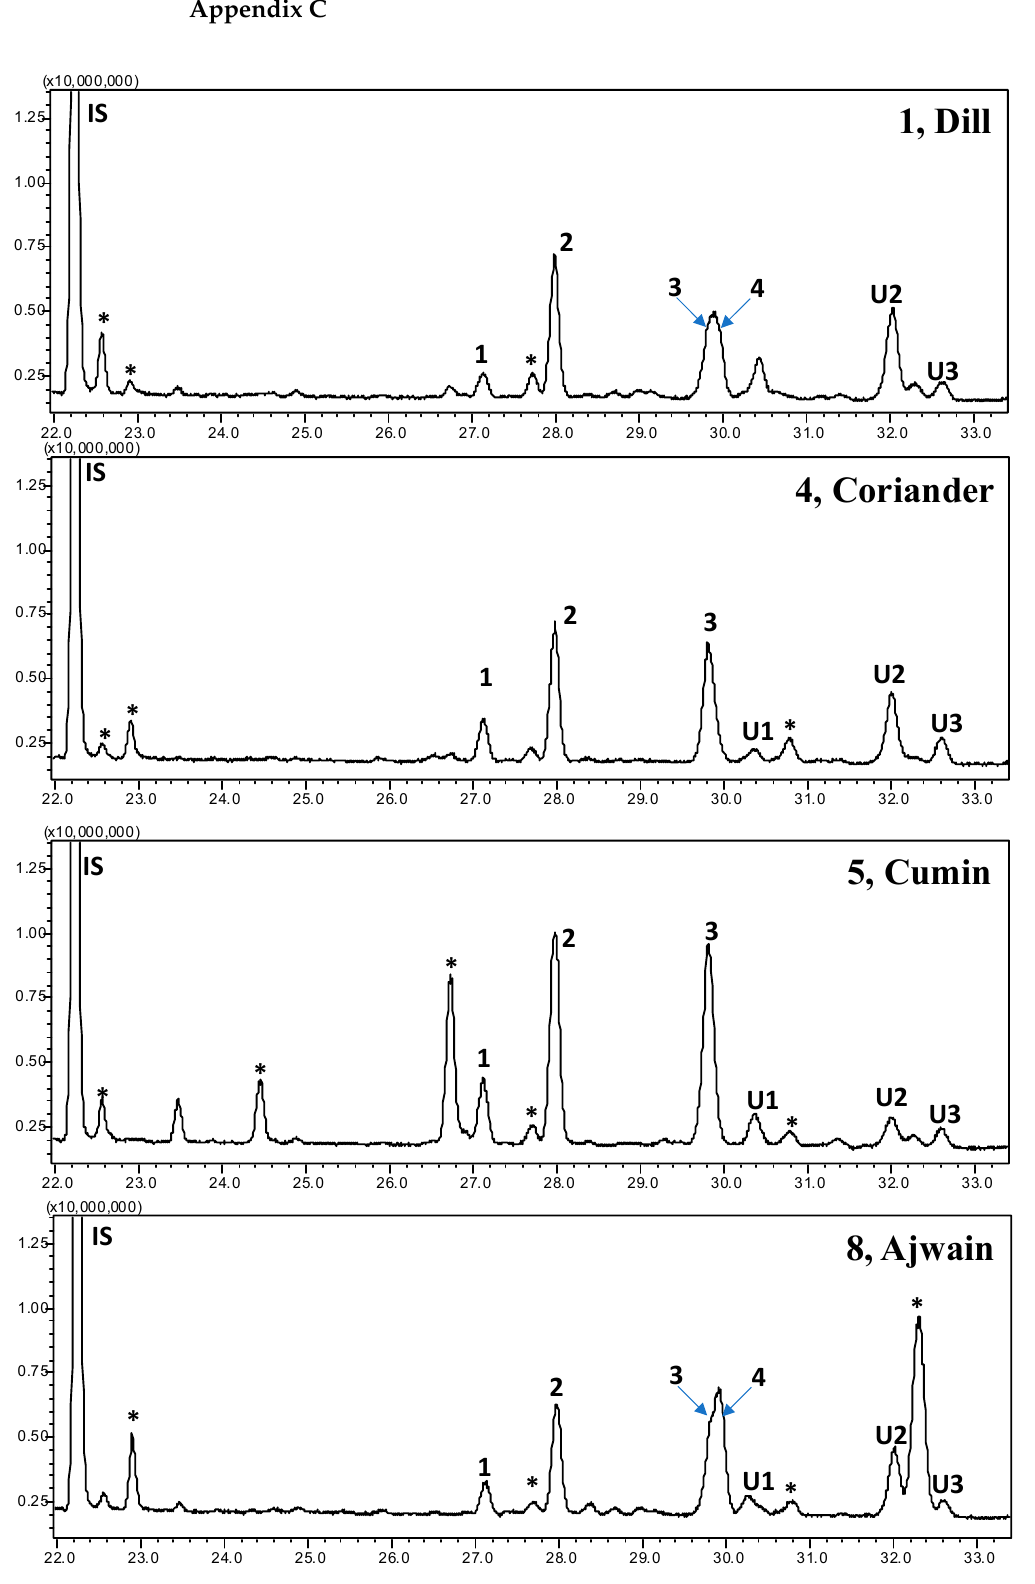
Figure A3. The gas chromatography (GC)- total ion chromatograms (TICs) of sterols identified in cumin, fennel, anise, and Ajwain seeds (seed oil). The peak numbers are as follows: (1) campesterol, (2) stigmasterol, (3) β -sitosterol, and (4) α -spinasterol. IS: internal standard (epicoprosterol; 5 β -cholestan-3 α -ol; CAS 516-92-7); U: unidentified; * non-sterols com ‐ pounds.